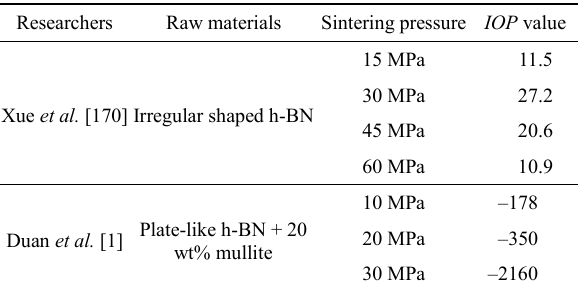
Fig. 17 Fracture morphologies of textured α-Al 2 O 3 specimens with different amount of seeds sintered at different temperatures for 4 h in air. Reproduced with permission from Ref. [3], © The Ceramic Society of Japan 2016. Table 3 Effect of sintering pressure on the texture degree of HPed h-BN matrix